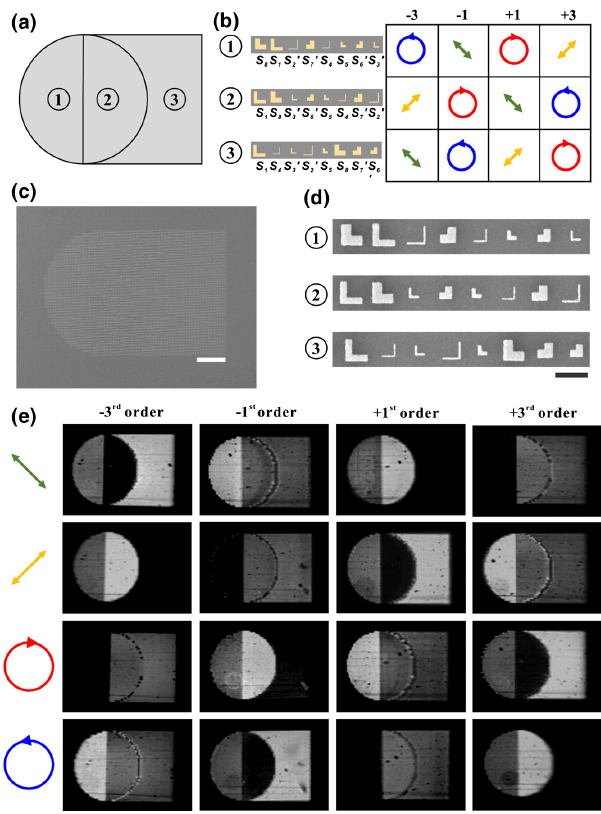
FIG. 6. (a) Schematic of the overlapped circle and square, where three regions (1, 2, and 3) can be identified. These regions are selected for polarization encoding. (b) Morphology of three types of unit cells f S 1 g , f S 2 g , and f S 3 g and the corresponding polarization states appearing at diffraction orders − 3 , − 1 , þ 1 , and þ 3 , respectively. Three different sequences are designated to regions 1, 2, and 3, respectively. The incident beam is x polarized. The green and yellow straight arrows represent the − 45 °-LP and þ 45 °-LP states. The blue counterclockwise (red clockwise) arrow represents the LCP (RCP) state. (c) Micrograph of the fabricated pattern. The bar represents 100 μ m. (d) SEM micrograph of the unit cell designated to regions 1, 2, and 3, respectively. The bar represents 1 μ m. (e) Diffraction images at orders − 3 , − 1 , þ 1 , and þ 3 visualized by the CCD camera. Four types of analyzers are put in front of the CCD, respectively, which is represented by the colored symbols on the left side. Two linear polarized analyzers are oriented at the − 45 ° (green arrow) and 45° (yellow arrow) directions, and two circular polarized analyzers are for RCP (red circle) and LCP (blue circle), respectively. Three different shades — bright, dark, and grey — appear at different regions depending on the selection of the